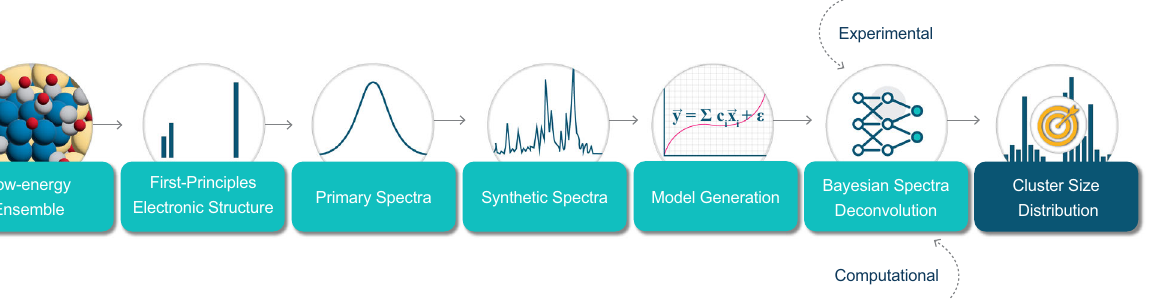
Fig. 1 | Schematic of the Bayesian infrared spectra deconvolution procedure. Our framework is composed of two major steps, inspired by the deconvolution of gas phase IR spectra: (1) generation of calibration spectra from fi rst principles (rather than experimentally) and (2) deconvolution of spectra. We determine a set of low-energy structures, deemed the low-energy ensemble, of supported metal clusters exposed to adsorbates at working conditions that contribute the most to the fi nal spectroscopic signature of the material. We compute the fi